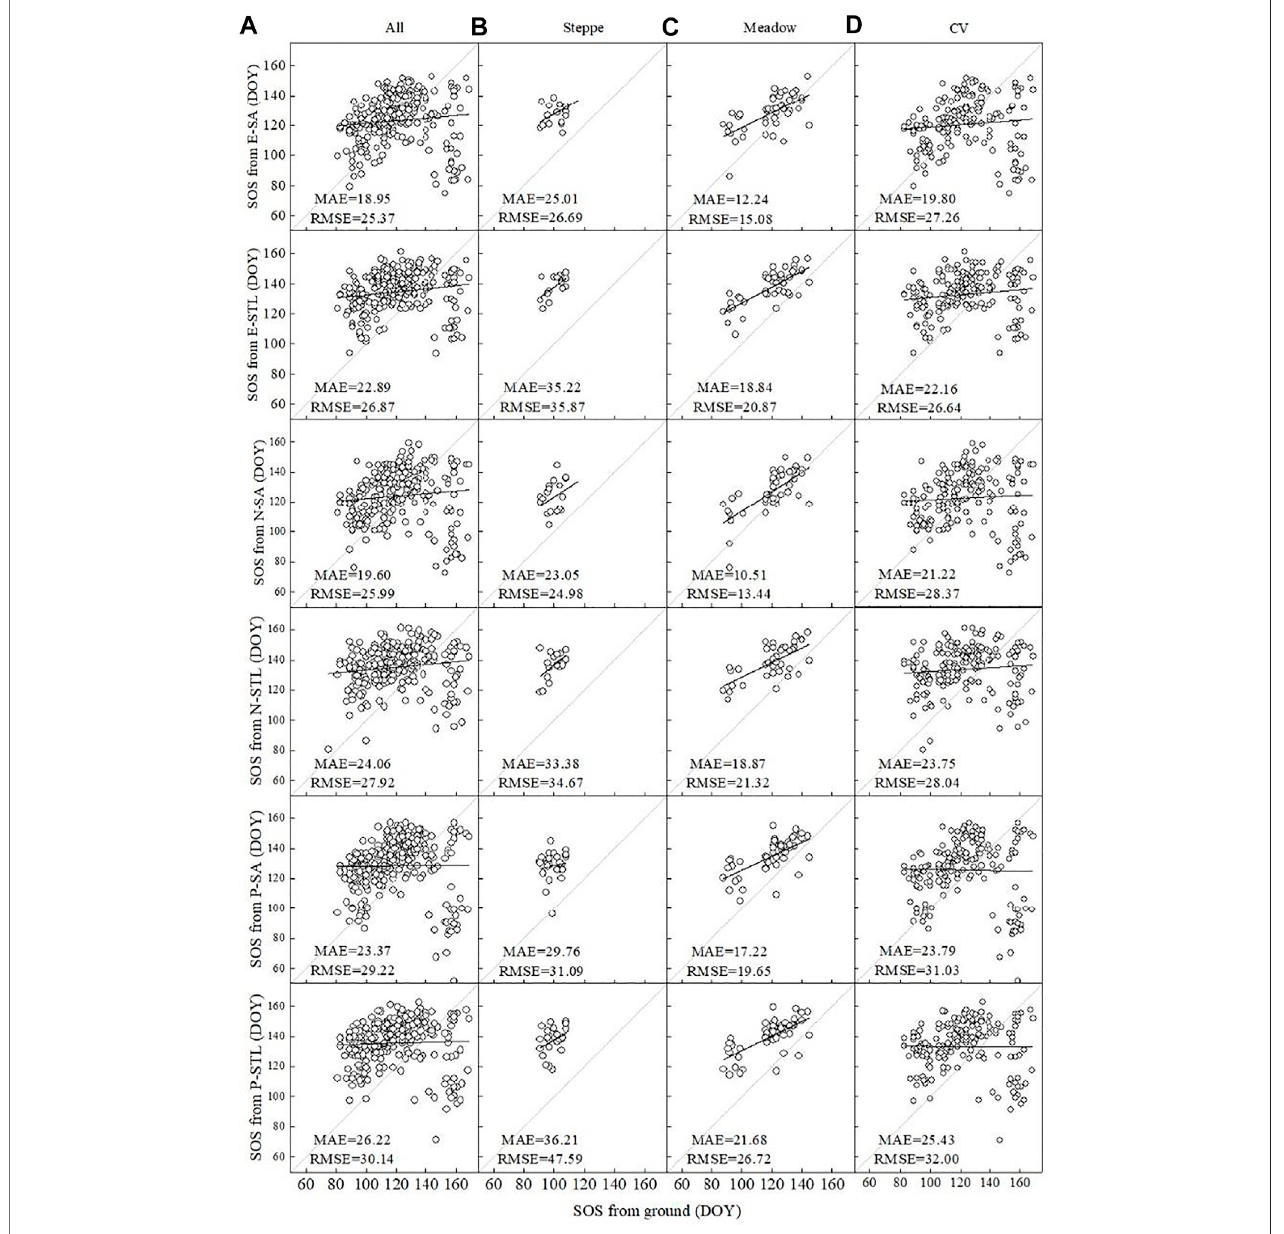
FIGURE5| ComparisonbetweenSOSfromE-SA,E-STL,N-SA,N-STL,P-SA,andP-STLfordifferentvegetationtypesbasedonthegroundobservations. (A) All, (B) steppe, (C) meadow, and (D) cultivated vegetation (CV). Gray lines are the 1:1 line, and black lines are the best linear regression line.